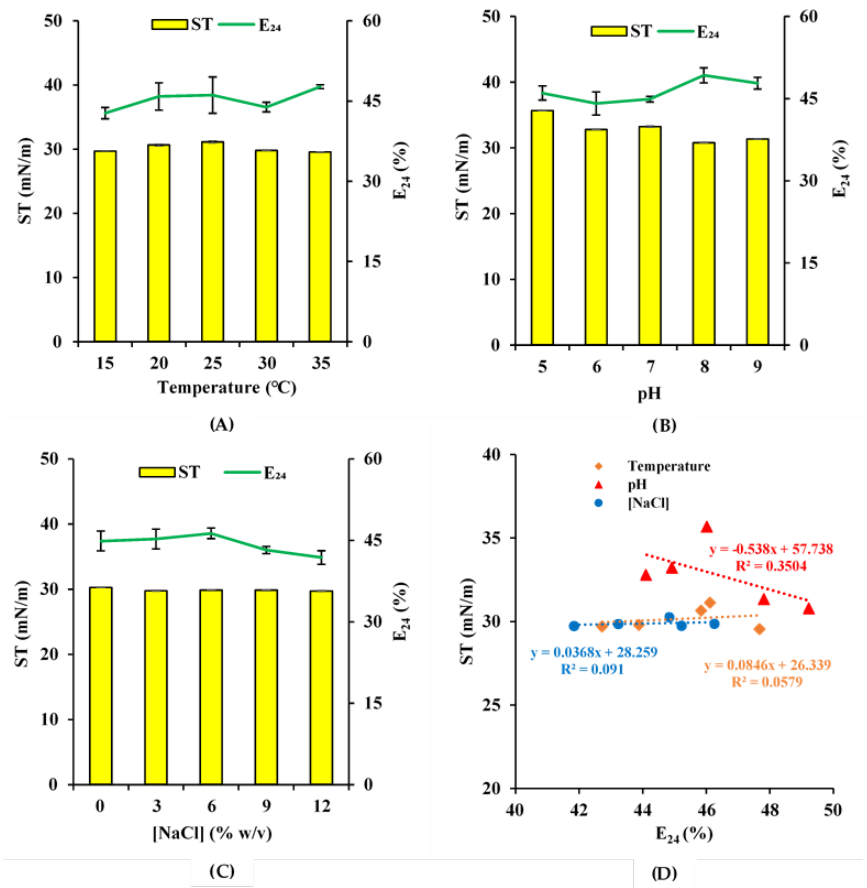
Figure 1. The stability of biosurfactants produced by Rhodococcus sp. ADL36 at di ff erent: ( A )temperature; ( B )pHand( C )salinity. ( D )Nosignificantcorrelationwasfoundbetweenemulsification index (E 24 ) and surface tension (ST) for temperature, pH and NaCl